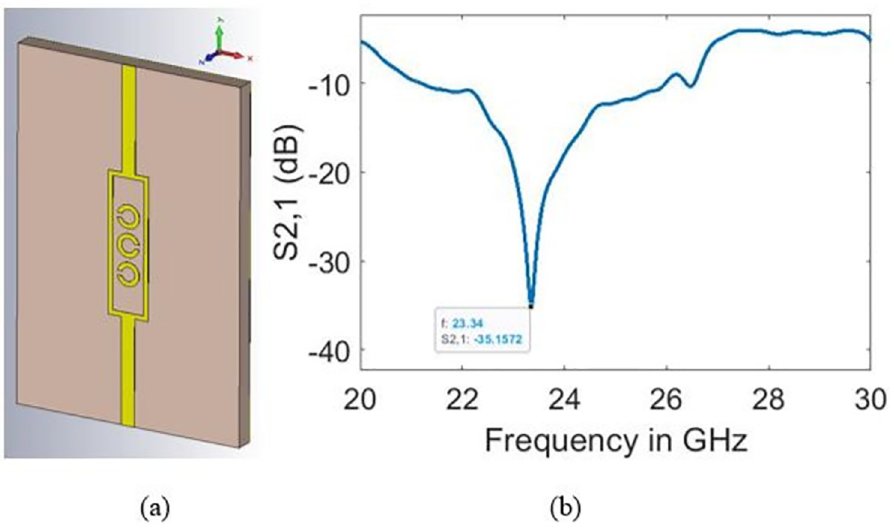
Fig 9. Three split-rings design (a) sensor design and (b) bare sample resonant frequency.